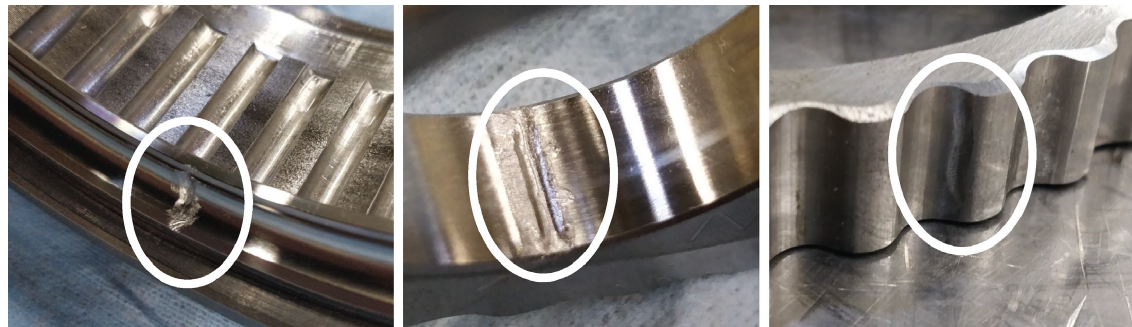
Figure 3: Gearbox artificial damages.